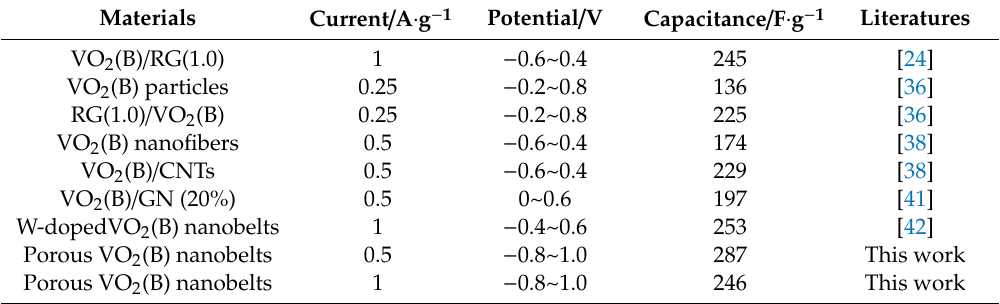
Figure 8. ( a ) CV cycling curves of the VO 2 (B) nanobelts (20 mV · s − 1 , 1 M Na 2 SO 4 electrolyte); ( b ) Cyclic stability of the specific capacitance (GCD method, 1 M Na 2 SO 4 electrolyte). Table 2. Comparison of the VO 2 (B) nanobelts with other materials discovered